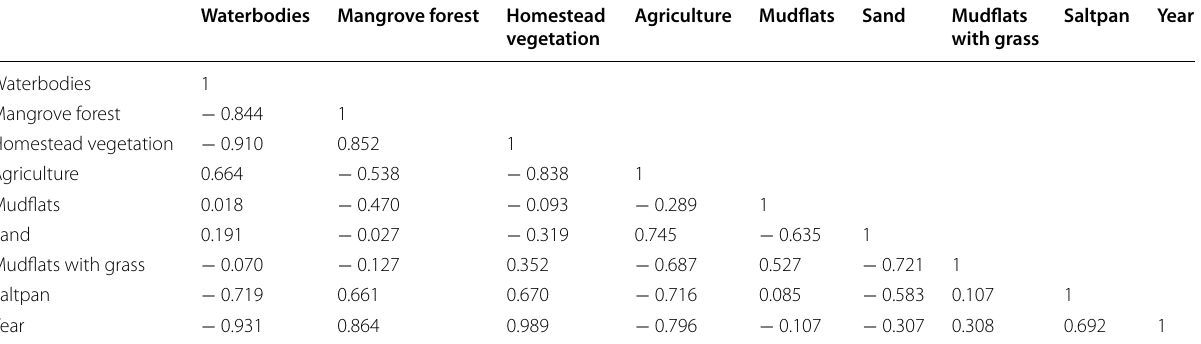
Table 4 Correlation matrix prepared for the whole study area of the coast